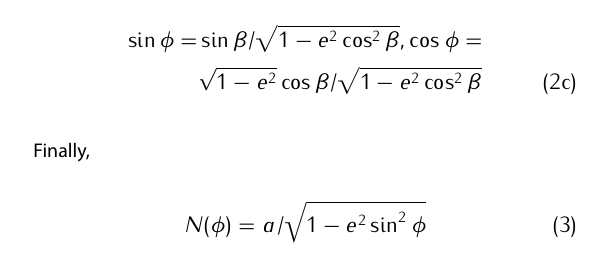
Figure 1. The GE projected to the